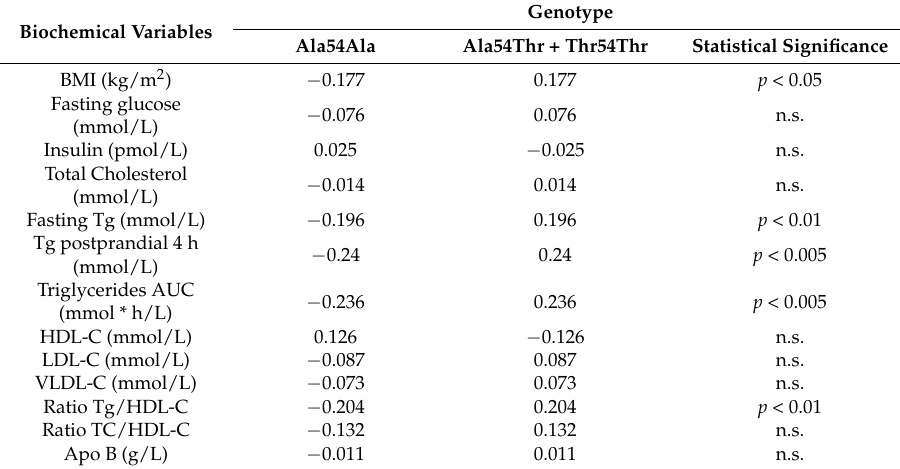
Table 4. Partial correlation coefficients between FABP2 genotype biochemical parameters and body mass index